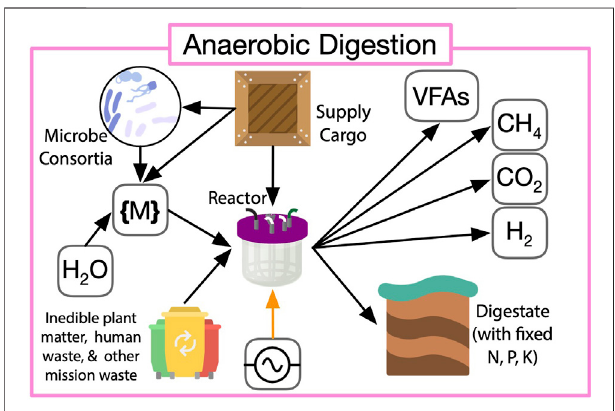
FIGURE 6 | LC-based (pink in Figure 2 ) anaerobic digestion of mission waste such as inedible plant matter, microbial biomass, human, and other wastes produce methane, volatile fatty acids (VFAs), and digestate rich with